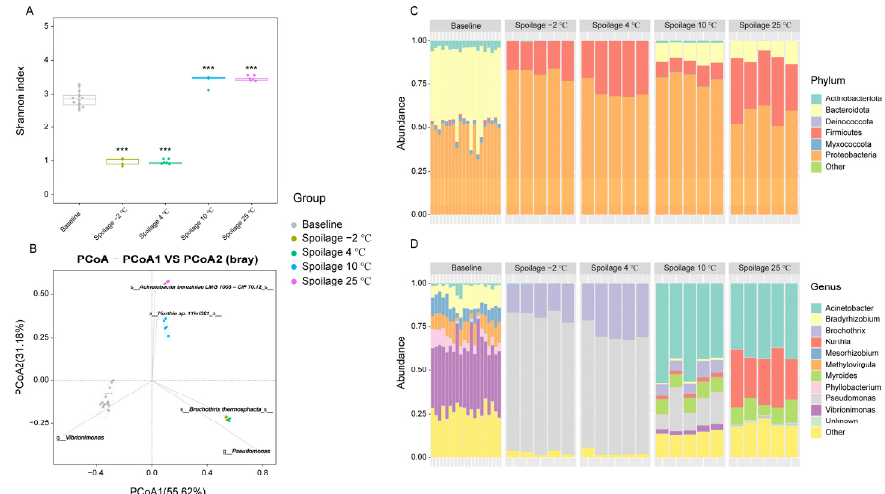
Figure 1. Effect of storage temperature on the microbial diversity and composition. ( A ) α diversity. Shannon index was analyzed at the OTU level. ***: indicates p value < 0.001. ( B ) β diversity. The principal coordinate analysis (PCoA) was performed based on the Bray–Curtis dissimilarity at the OTU level. ( C ) Microbial composition at the phylum level. ( D ) Microbial composition at the genus level.